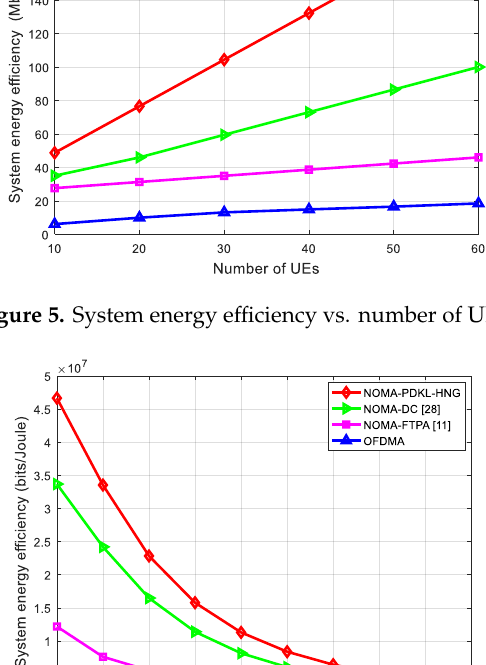
Figure 5. System energy efficiency vs. number of UEs.